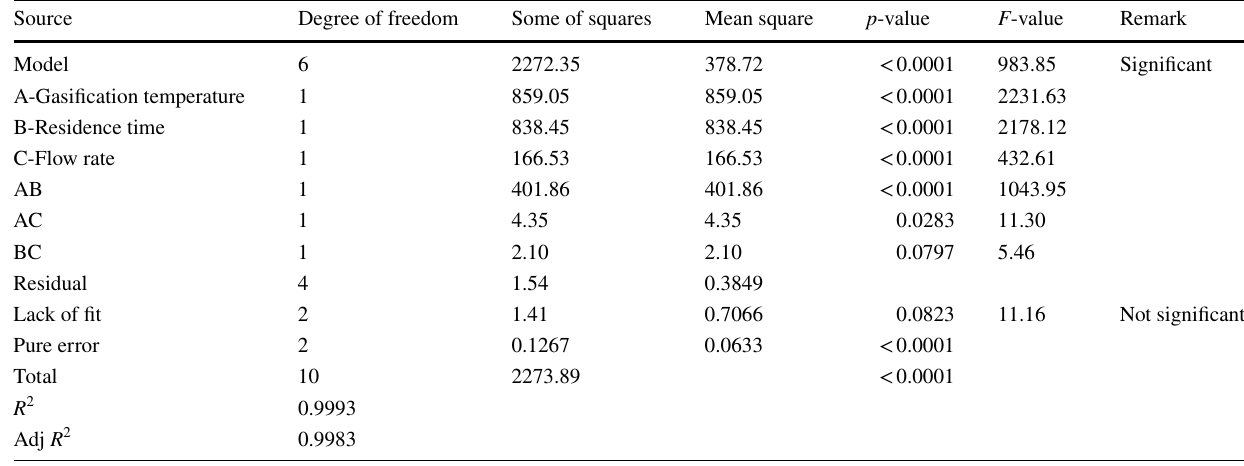
Table 8 ANNOVA analysis of LVWC− I gasification Source Degree of freedom Some of squares Mean square